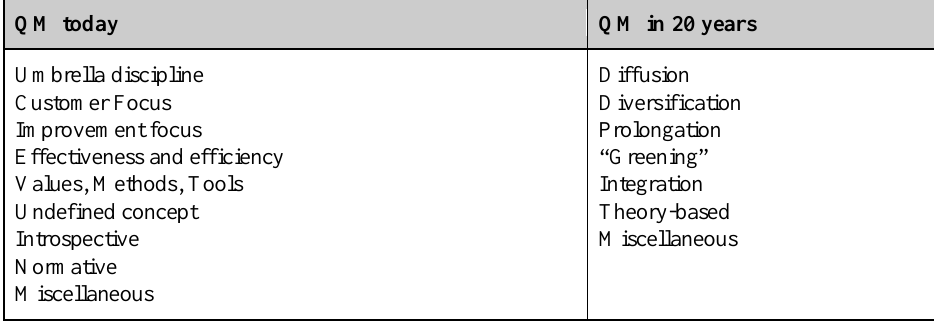
Table 2 – Notes clusters from the workshop at Luleå University of